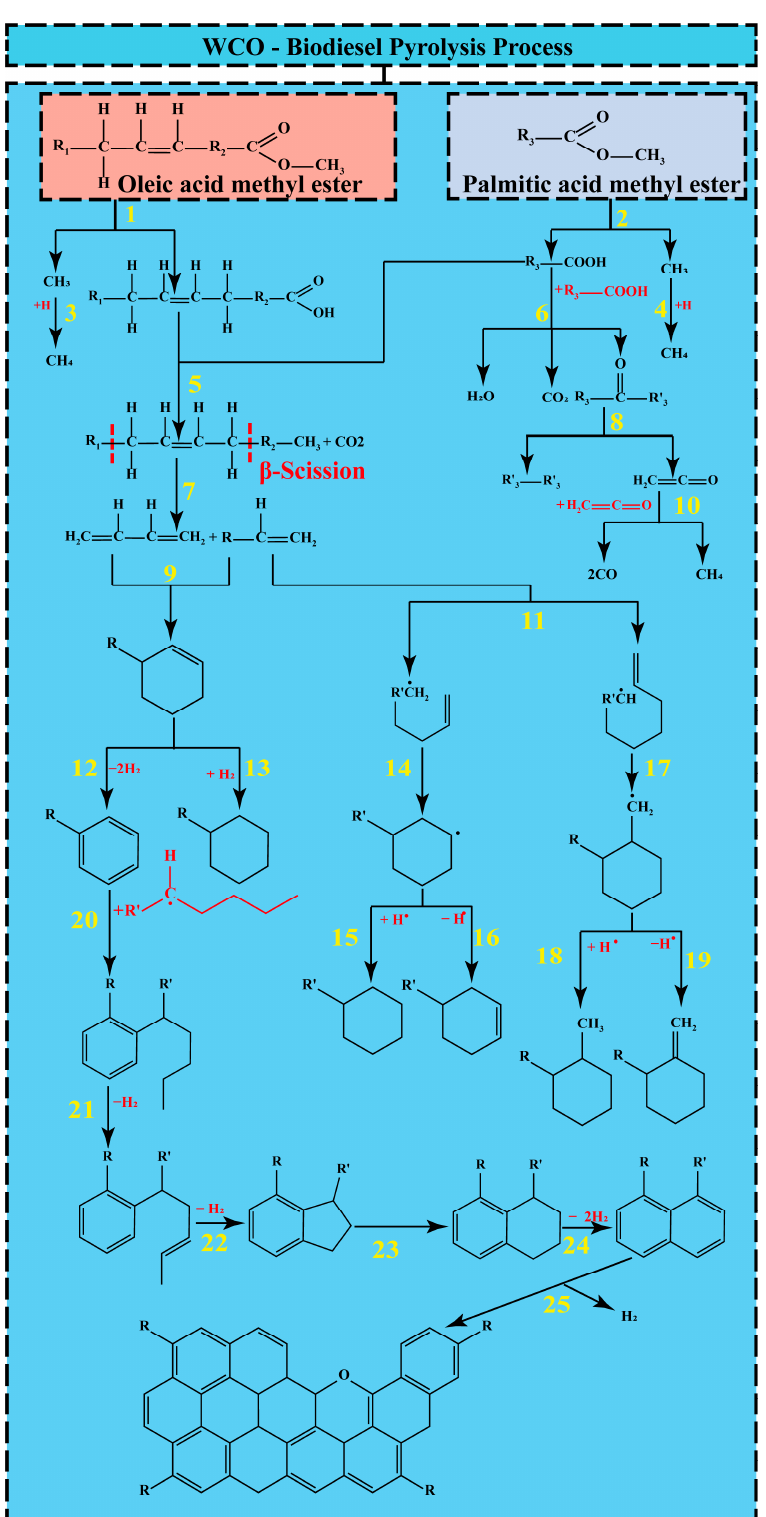
Figure 12. The possible rapid pyrolysis reaction mechanism of WCO-Biodiesel .